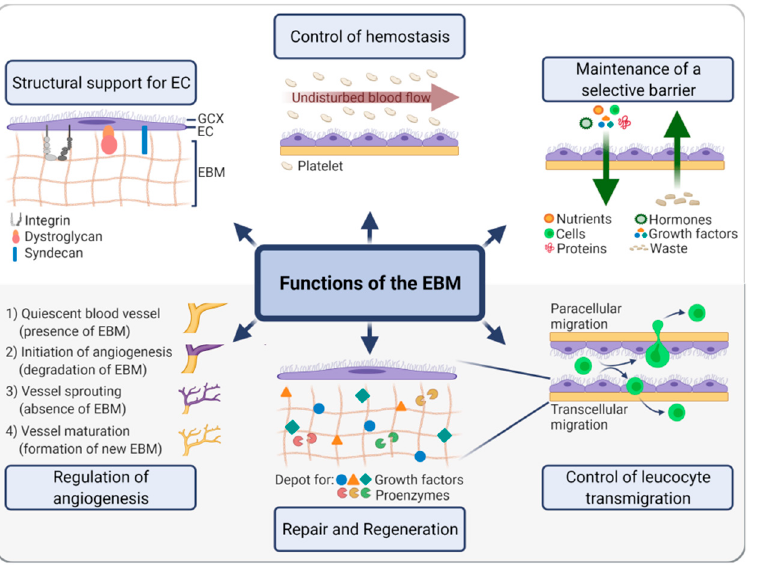
Figure 3. Functions of the endothelial basement membrane (EBM). The EBM confers structural support to endothelial cells (EC) through integrins, dystroglycans, and syndecans. In this context, it indirectly controls hemostasis through EC and thus allows an undisturbed blood flow preventing platelet adhesion. It also functions as a selective barrier for molecules, cells, and waste products. In particular, the migration of leucocytes at events of inflammation is controlled by the EBM. Moreover, the EBM can be considered a depot for numerous growth factors and proenzymes, which are released to induce tissue repair and regeneration. Ultimately, the EBM is a crucial regulator of